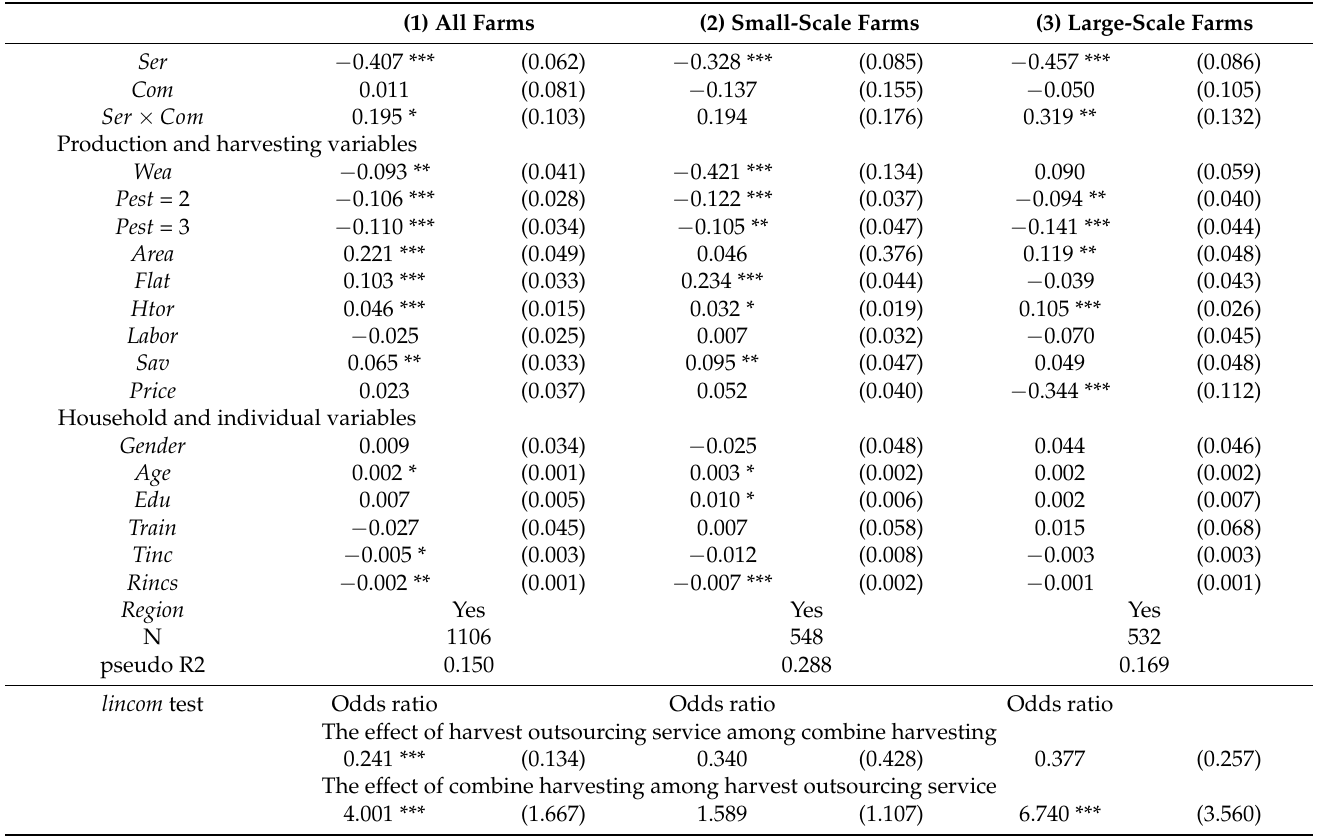
Table 4. Marginal effects with the cross